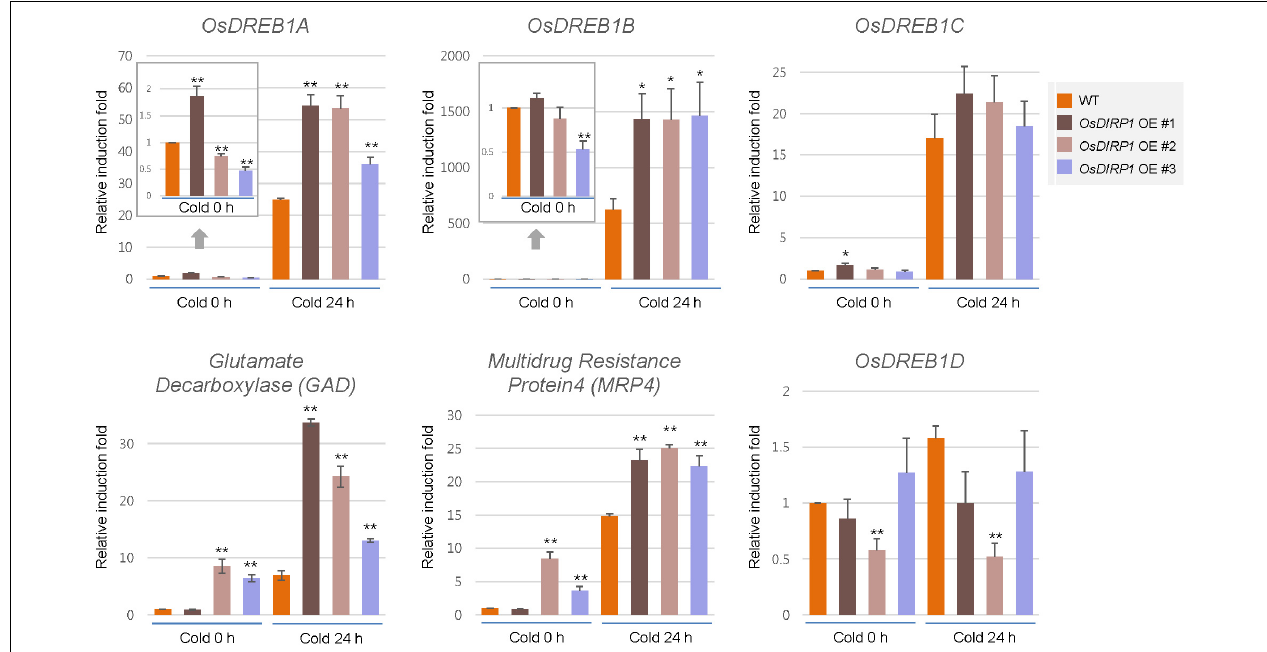
FIGURE 7 | Expression analysis of cold stress-inducible genes in wild-type and OsDIRP1 -overexpressing transgenic rice plants. Light-grown, 10-day-old wild-type and Ubi:OsDIRP1-sGFP transgenic plants were exposed to cold (4 ◦ C) stress for 0 or 24 h. The induction patterns of five stress-responsive genes, OsDREB1A , OsDREB1B , OsDREB1D , GAD , and MRP4 , were analyzed by real-time qRT-PCR. The relative expression of each gene was normalized to that of OsActin . Data are means ± SE ( ∗ P < 0.05, ∗∗ P < 0.01, Student’s t -test) of three independent